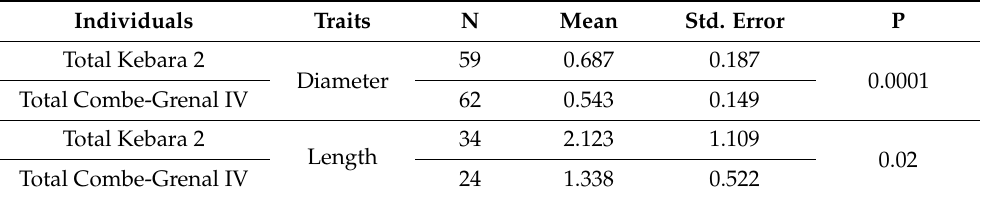
Table 3. Statistical analysis of the total lengths and diameters of the tartar bacteria from Combe-Grenal IV and Kebara 2.